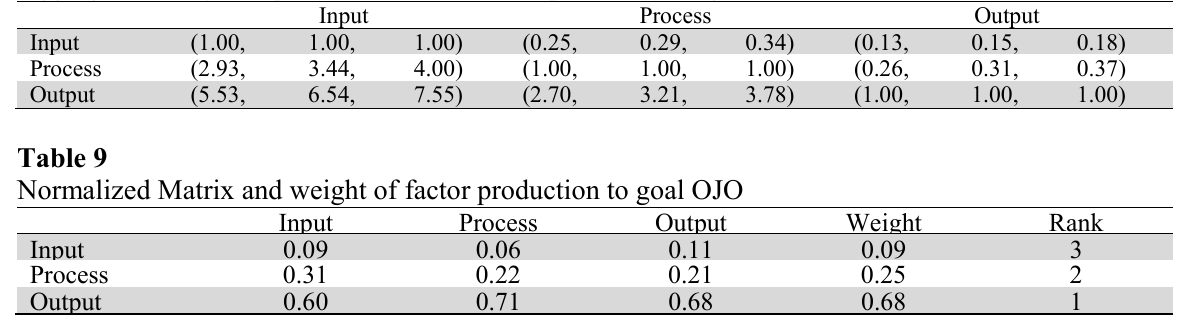
Aggregated fuzzy comparison matrix of factor production to goal OJO